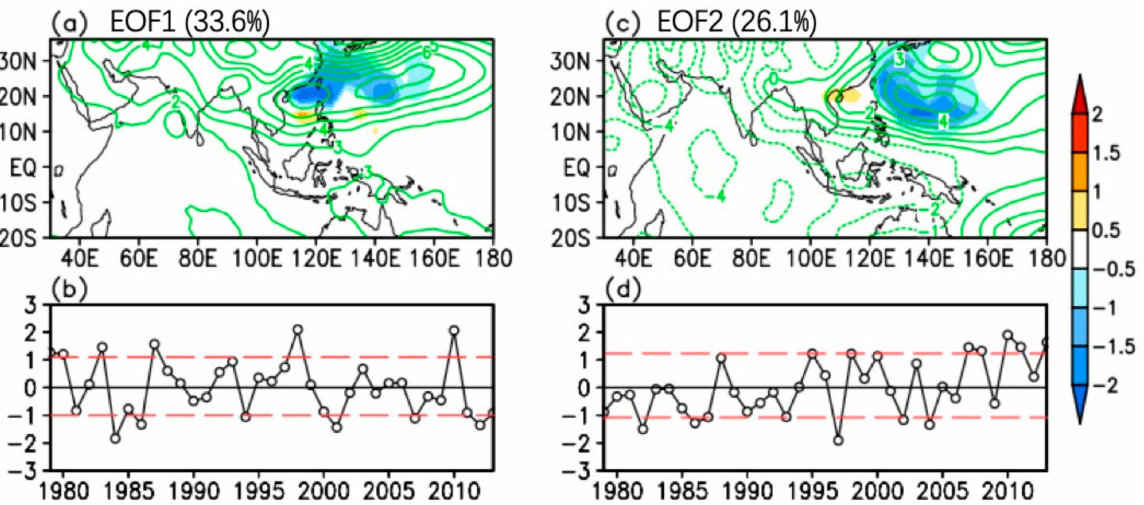
Figure 1. ( a ) The regression map of 850-hPa geospatial height (contour) and storm days (shading) with reference to the PC of EOF1 mode ( b ) derived from the JJA 850-hPa geopotential height over the WNP basin during 1979–2014. Panels ( c , d ) are the same as in Panels ( a , b ), respectively, but for the second mode (EOF2). The red dashed line in Panels ( b , d ) marks six positive years (H) and six negative years (L) for both PC1 and